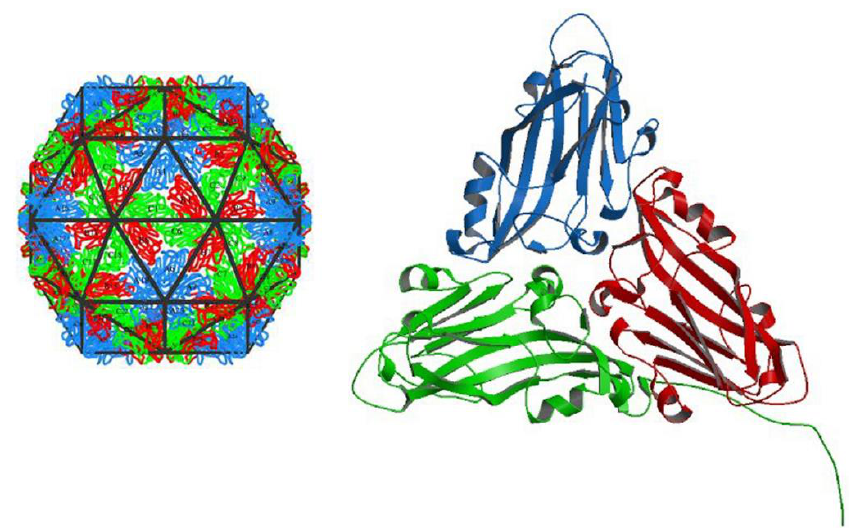
Figure 3. Cocksfoot mottle virus capsid. Sobemovirus capsid is assembled according to T=3 icosahedral lattice symmetry. The CP monomers are chemically identical but exist in three slightly different conformations, denoted as A (blue), B (red) and C (green) subunits. The A, B and C subunits build one icosahedral subunit (on the left). Altogether, there are 60 icosahedral subunits per sobemoviral T=3 particle (on the right). The A subunits interact at the icosahedral fivefold axes to form 12 pentamers while the pairs of B and C subunits meet at icosahedral threefold axes to form 20 hexamers. The pentamers and hexamers differ significantly in shape—hexamers are generally planar and pentamers are substantially bent. The combination of hexamers and pentamers gives the particle its characteristic